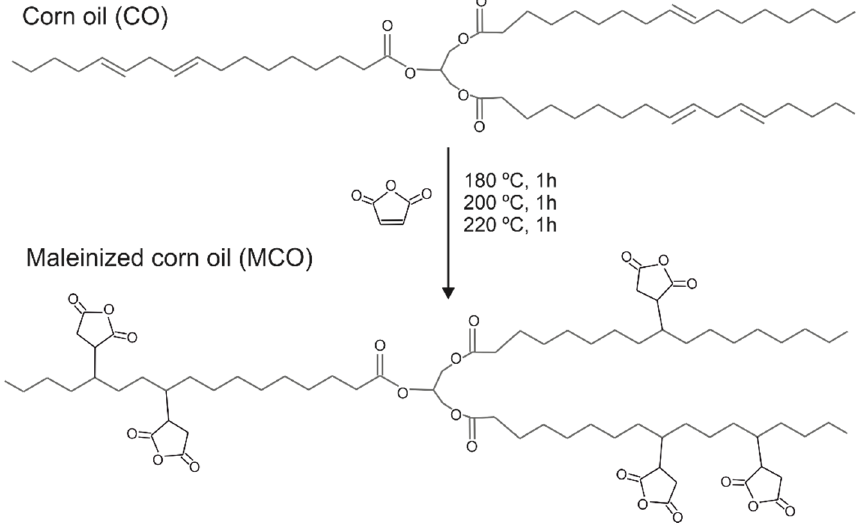
Figure 1. Schematic representation of the maleinization process of corn oil. White silk cocoons used in the experiments (see Supplementary Material Figure S2)